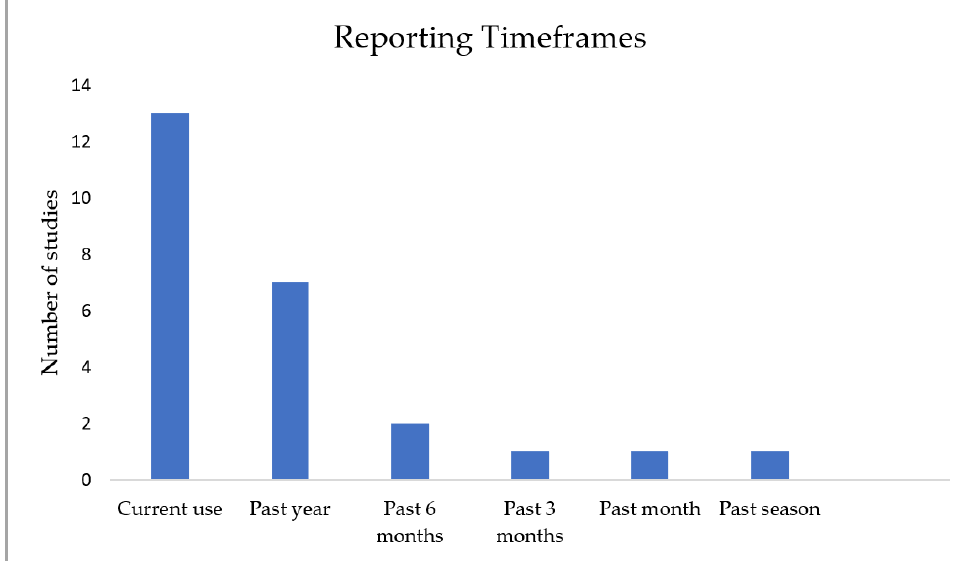
Figure 2. Summary of studies’ demographics.